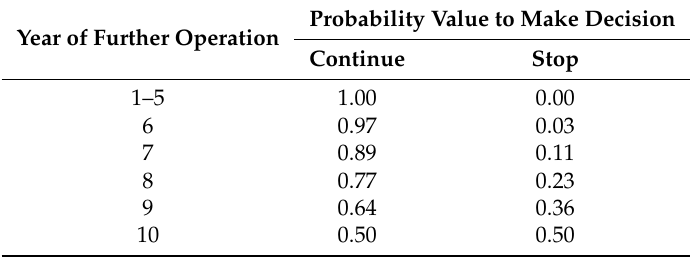
Table 4. Probability of the continuation or abandonment for all analyzed onshore wind power plants in the next 10 years after EEG levy expiration, for O&M costs equal to 1.81 e -ct/kWh and 2.74 e -ct/kWh.